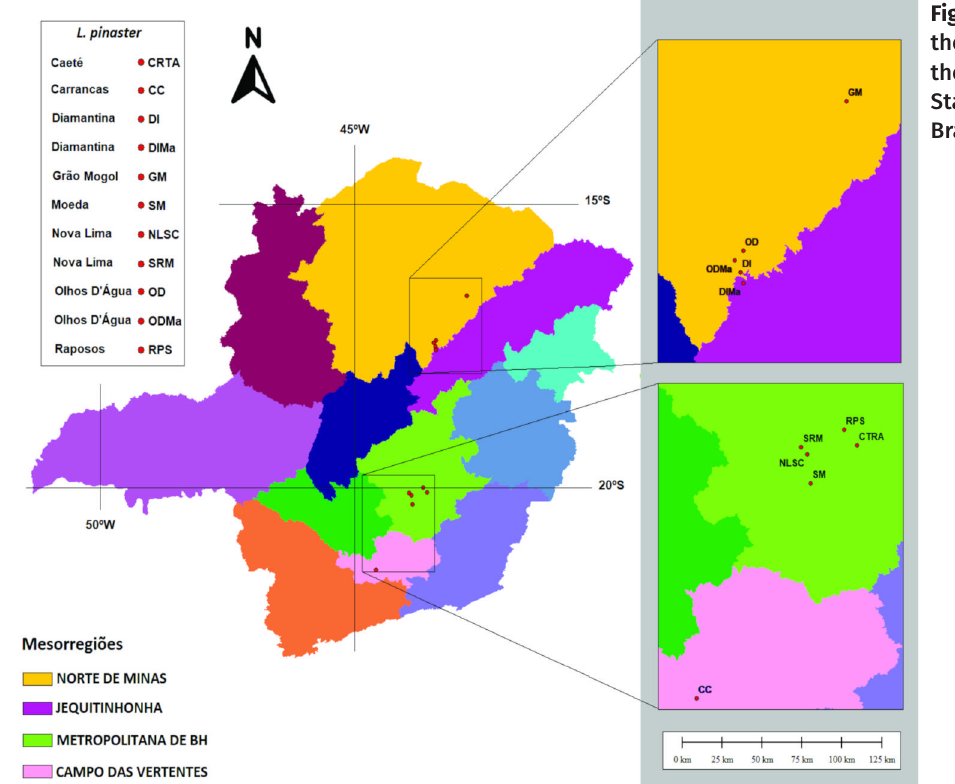
Figure 1. Map showing the sampling sites in the mesoregions of the State of Minas Gerais,